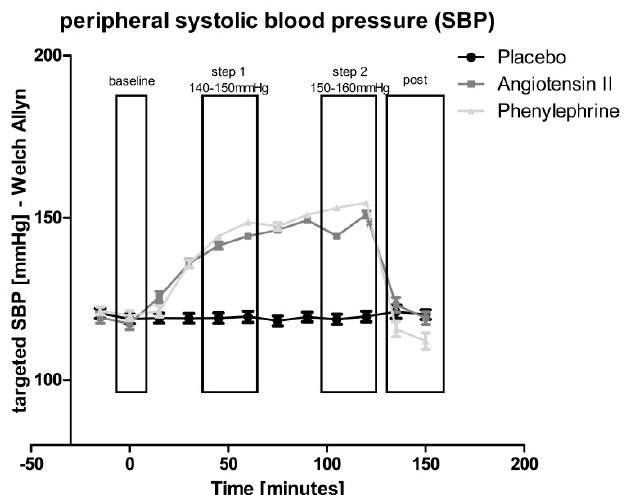
Figure 1. Oscillometric brachial systolic blood pressure (SBP) readings for dose titration of Angiotensin II (Ang II) (dark-grey) or phenylephrine (PE) (light-grey) vs. placebo (black). SBP was almost equivalent between both vasoconstrictors as intended, and was maintained at target level of about 140(–150) mmHg (step 1) and 150(–160) mmHg (step 2) during the respective 30-min steady-state recording periods.